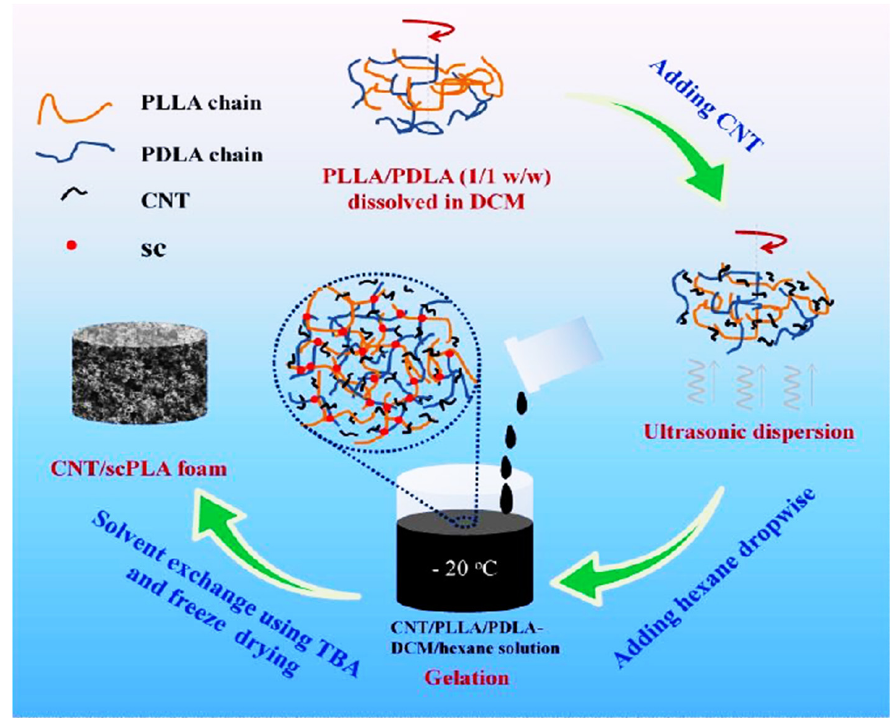
Figure 13. Schematic demonstrating the fabrication process of PLA/CNT foams. Reproduced with permission from [115]. Copyright 2017, Elsevier Ltd.